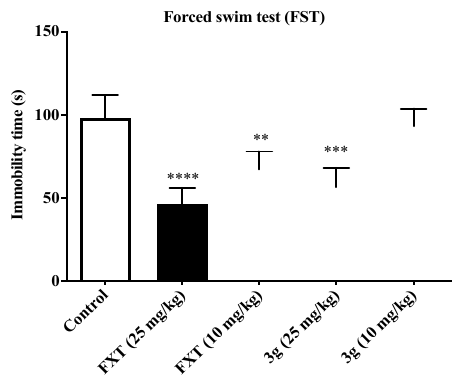
Figure 3. Effects of compound 3g and FXT (i.p., 10 mg/kg and 25mg/kg) on the duration of immobility time in the FST at lower dosages. Ten animals were used for each group. ** p < 0.01 compared to the control group, *** p < 0.001 compared to the control group, **** p < 0.001 compared to the control group.